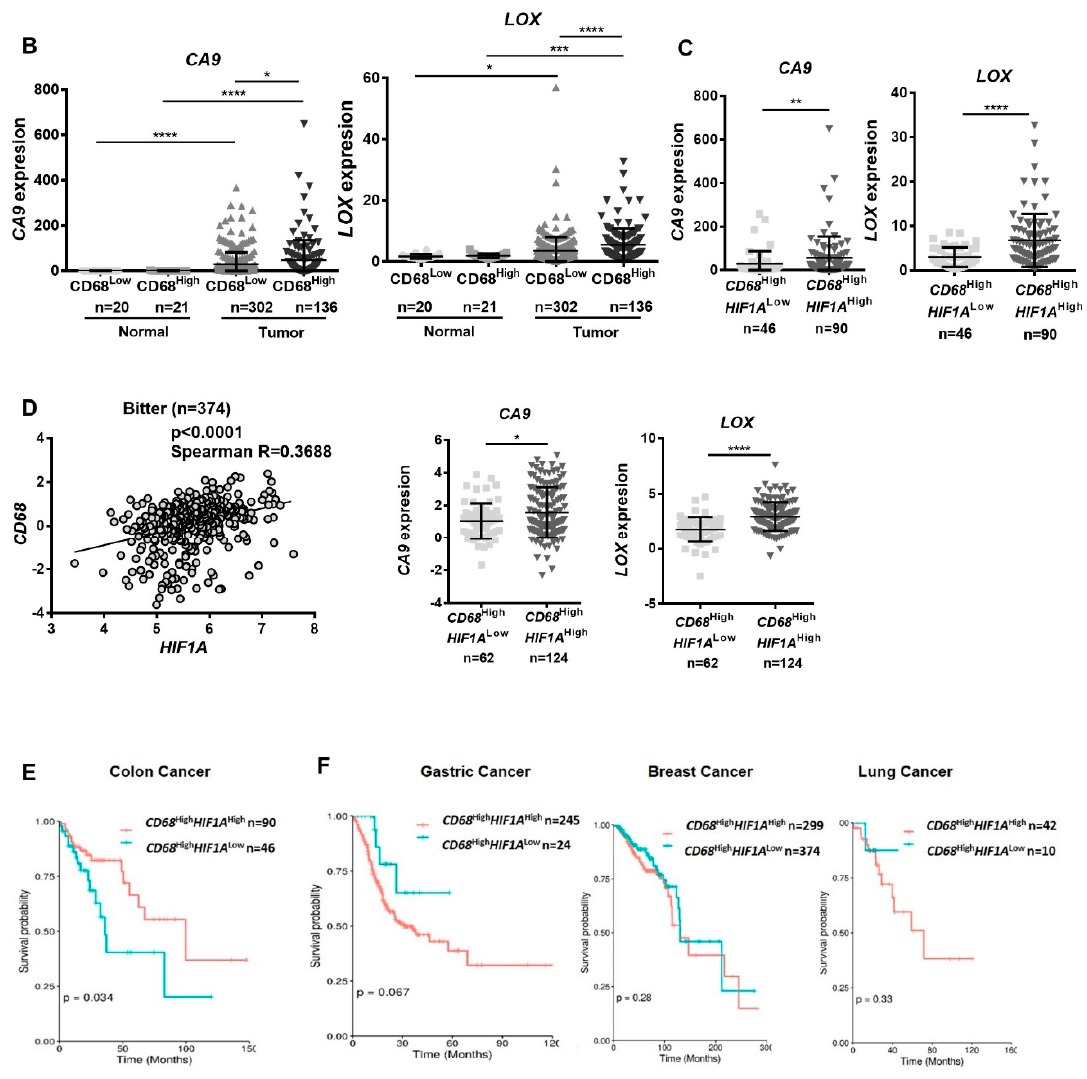
Figure 1. CD68 and HIF1A are positively correlated in colon cancer, and CD68 High HIF1A High tumors present better prognosis. Microarray and RNASeq expression data were downloaded from The Cancer Genome Atlas (TCGA) ( A – C , E – F ) and from Oncomine databases ( D ). ( A – C ) Normal and tumor samples were divided into CD68 Low and CD68 High , according to the median levels of CD68 expression in normal samples. In each group, the expression of the hypoxic marker HIF1A ( A ), CA9 and LOX ( B , C ) genes, known to be regulated by HIF1 α in hypoxic conditions, was evaluated. ( A ) The correlation between CD68 and HIF1A was assessed. ( B , C ) The expression of CA9 and LOX was evaluated in both normal and tumor samples, in CD68 High and CD68 Low populations, and within the CD68 High population, the expression levels of both genes were compared between HIF1A Low and HIF1A High , according to the median levels of HIF1A expression in normal samples. ( D ) Correlations between CD68 and HIF1A , and LOX and CA9 expression in CD68 High HIF1A High patients were confirmed on Bittner’s colon cancer cohort from Oncomine. ( E , F ) Kaplan–Meier curves were made with patients’ survival data, comparing the populations CD68 High HIF1A High and CD68 High HIF1A Low . The division high / low expression was made according to the median expression of the selected genes in normal tissue ( A – C ; E – F ), or by the median expression of tumor ( D ). Data from colon ( E ), gastric, breast, and lung ( F ) cancer patients were analyzed. Kruskal–Wallis, Mann–Whitney, or unpaired t -test were used to compare gene expression among groups. Spearman’s statistical test was used to assess correlation, which was considered moderate positive when Spearman Rs were between 0.2500 and 0.3500, and strong positive when Spearman R > 0.3500. Long-rank (Mantel–Cox) test was performed in the analysis of the survival curves. **** p < 0.0001; *** p < 0.001; ** p < 0.01; * p < 0.05.